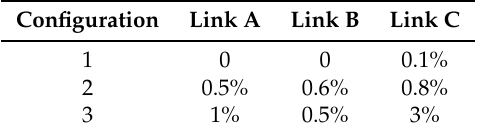
Table 3. Different configurations of packet loss